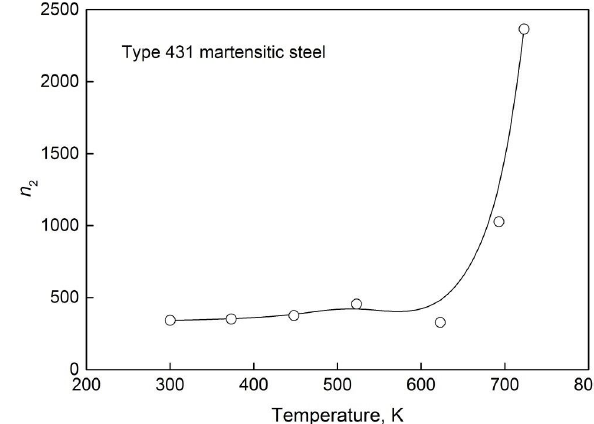
Figure 16: Variation of Ludwigson work hardening parameter n 2 with temperature for the AISI 431